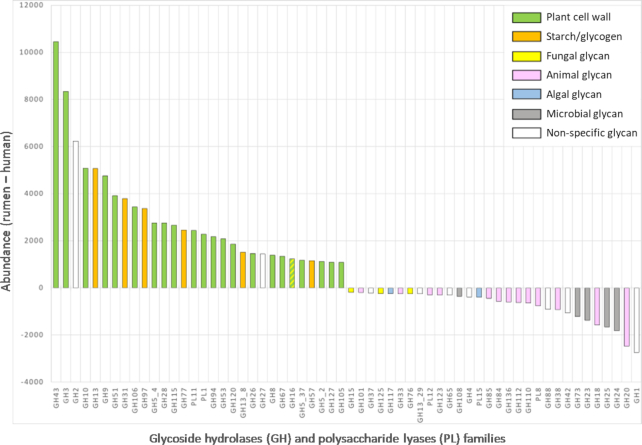
Enrichment or depletion of glycoside hydrolases and polysaccharide lyases in the bovine rumen as compared to human gut. Human counts were normalized to rumen catalog size before comparison.